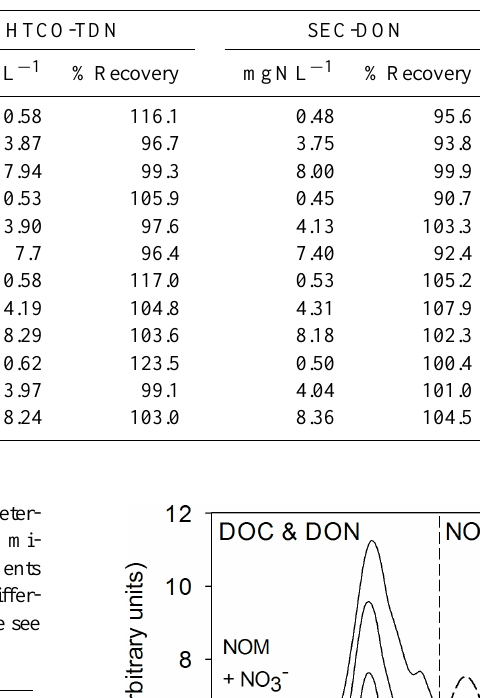
Table 2. Measured concentrations and recovery rates of HTCO-TDN (6–15 measurement replicates) and SEC-DON (2–7 measurement replicates) for four standard compounds at three standard concentration levels (Std. conc.). Please see Table 1 for further details on the samples.